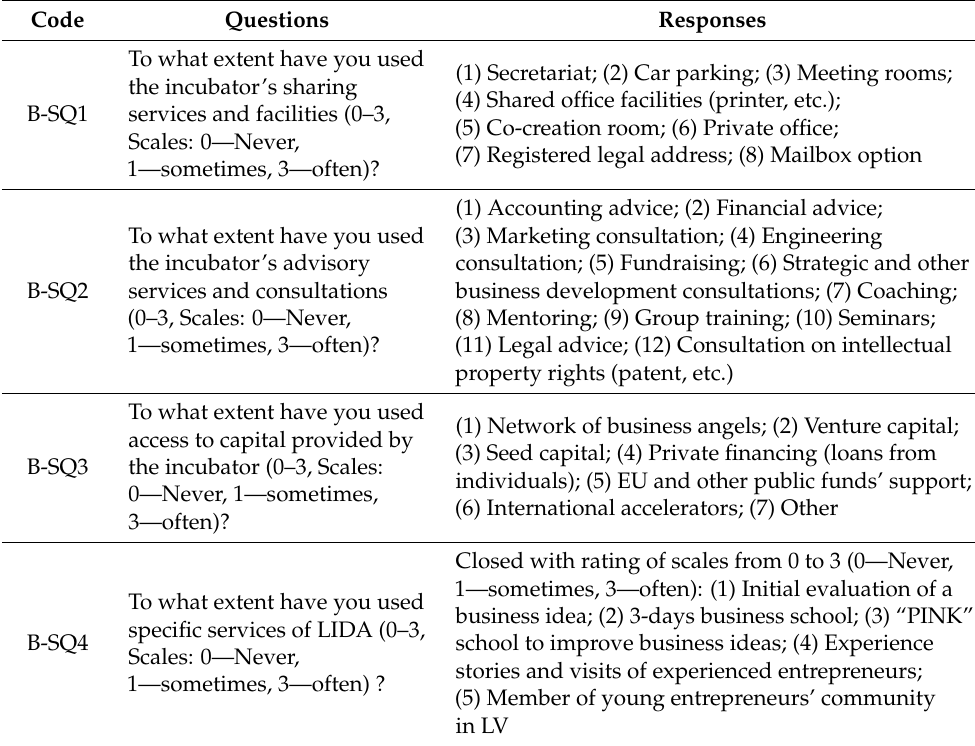
Table A3. The use of the incubator’s services